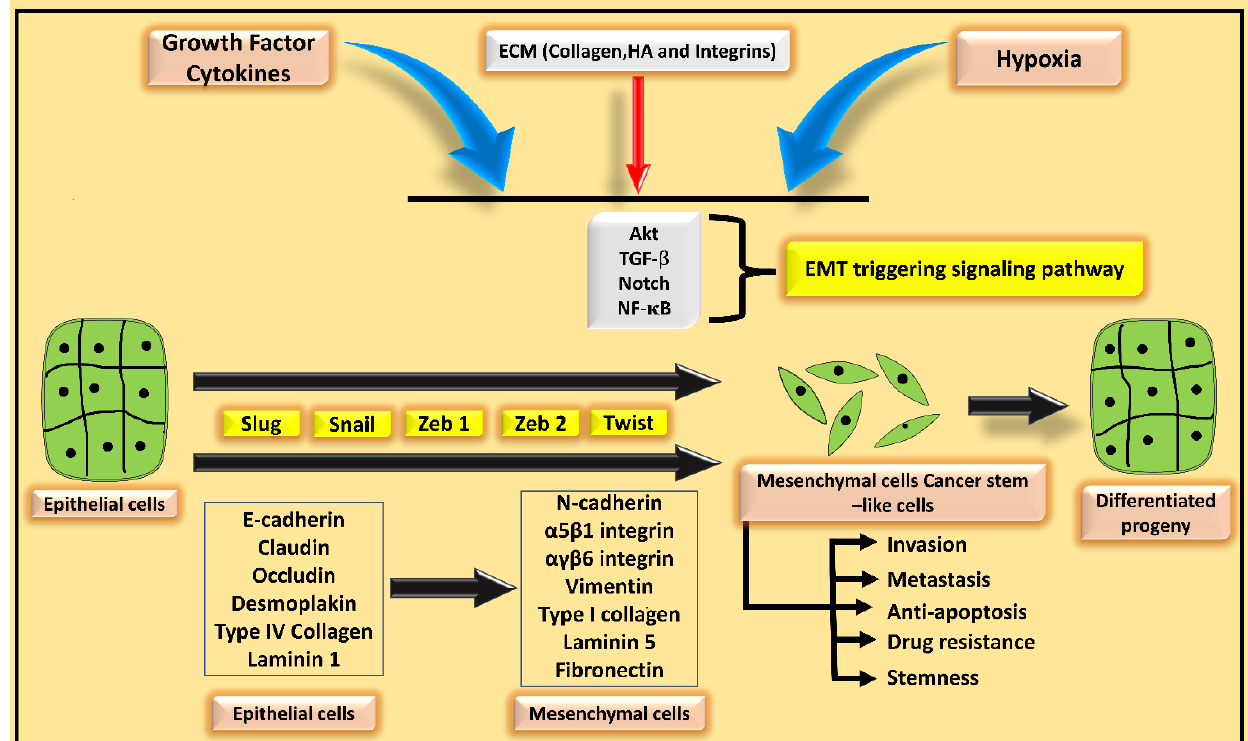
Figure 1. Hypoxia, growth factor, cytokines, and ECM activate the pathways that can trigger the EMT by activating EMT transcription factors (EMT-TFs), including SNAIL, SLUG, and the basic helix–loop–helix factors TWIST. As proven for SNAIL, TWIST, Zinc figure E-box binding homeobox 1 (ZEB1), and ZEB2, these features can repress epithelial genes like the E-cadherin-producing CDH1 by binding to E-Box in their cognate promoter regions. Simultaneously, EMT-TFs activate genes associated with a mesenchymal phenotype, such as Vimentin (VIM), Fibronectin 1 (FN1), and N-Cadherin (CDH2), etc.